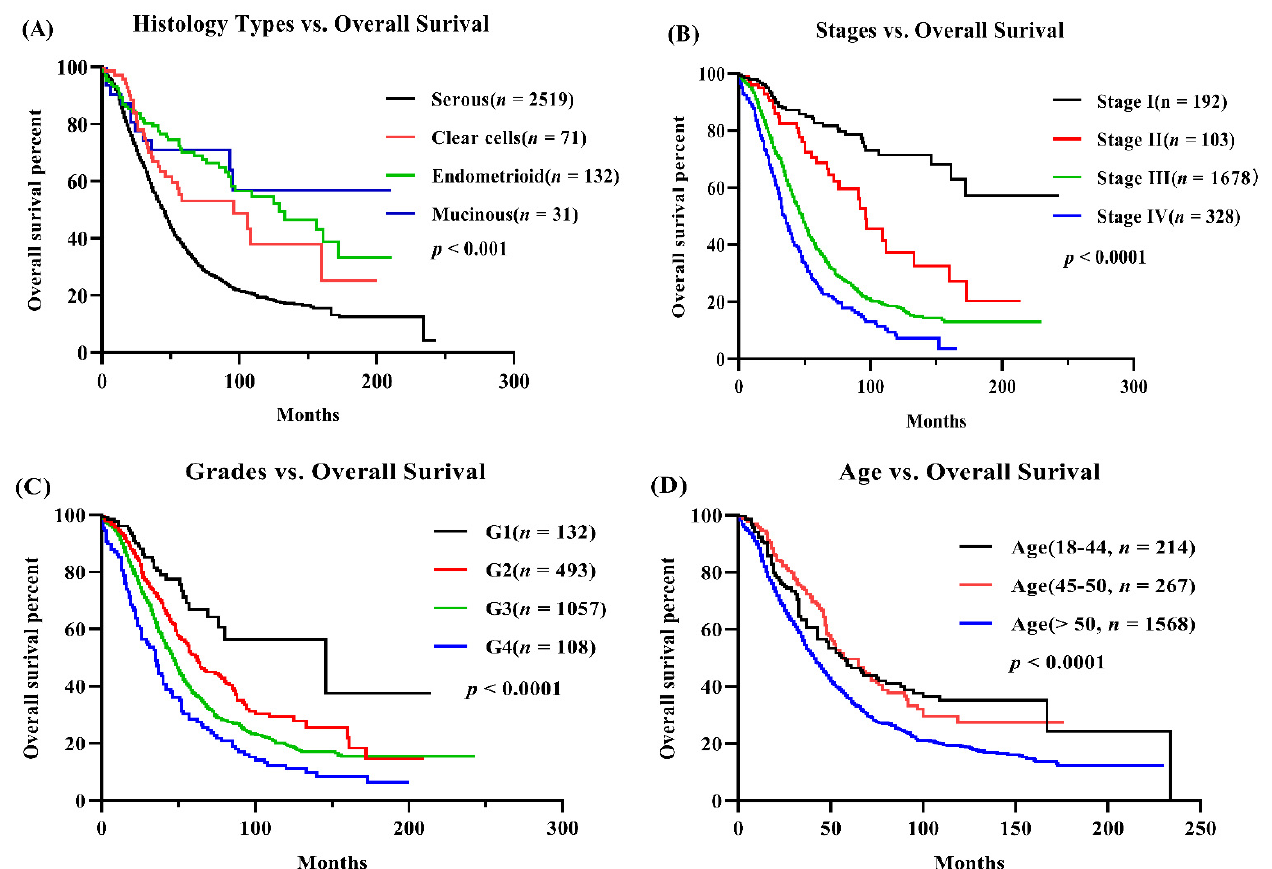
Figure 1. Clinico-pathological factors affect overall survival in ovarian cancer. ( A ) Histological types vs. overall survival (OS) of ovarian cancer; ( B ) Stages vs. OS; ( C ) Grades vs. OS; ( D ) Age vs. OS.